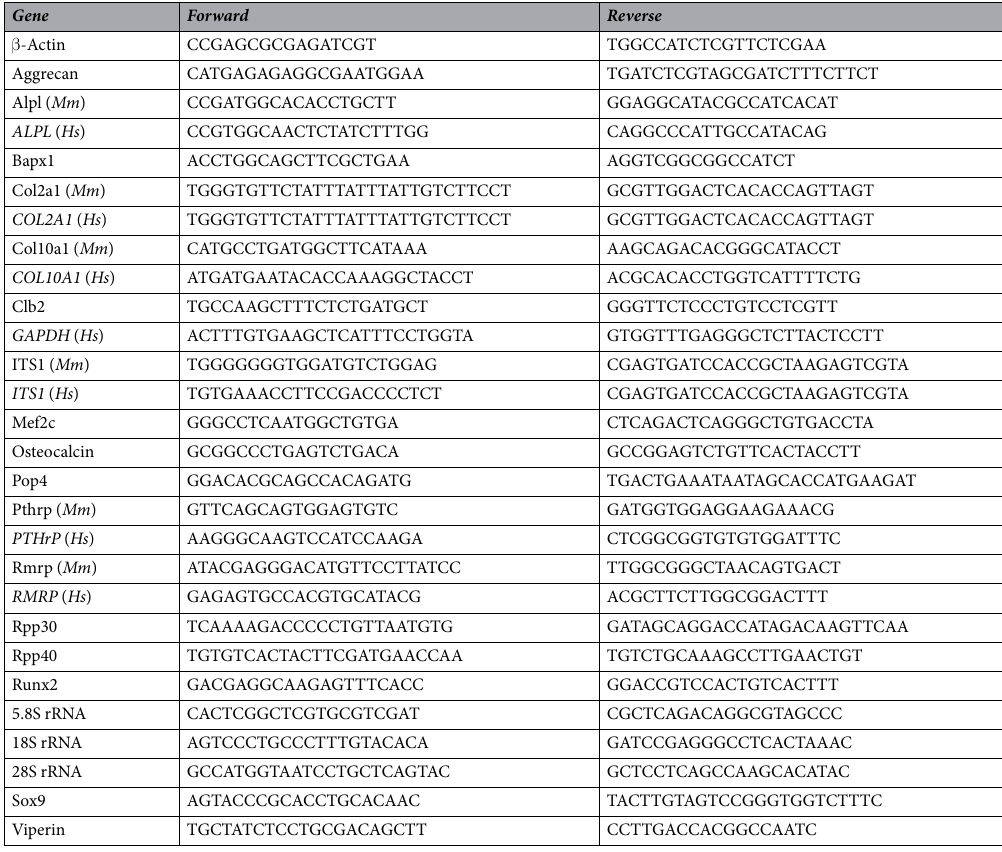
Table 2. RT-qPCR primer sequences. When not specified, primer sequences were designed for Mus musculus . In table Mus musculus is abbreviated as Mm and Homo sapiens as Hs